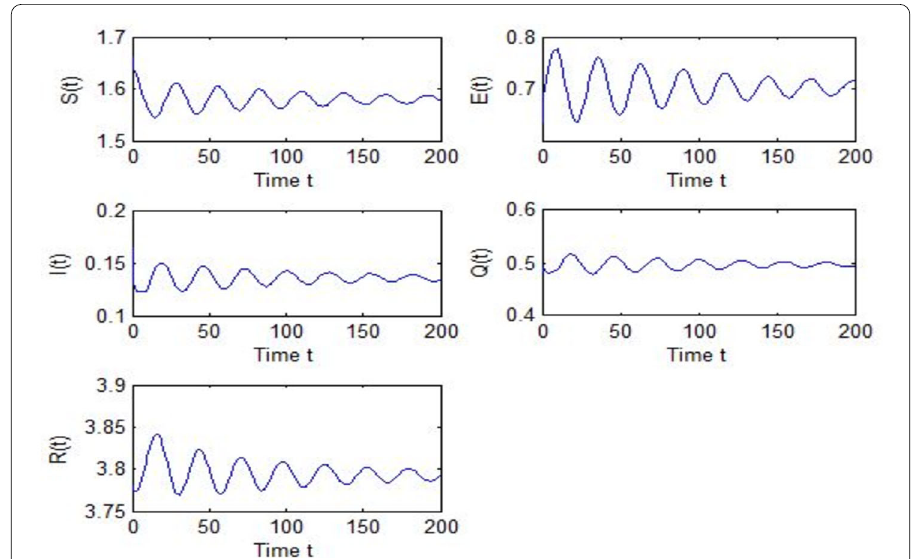
Figure 2 Evolutions of S , E , I , Q , R for τ 1 = 9.7291 > τ 10 along with time t